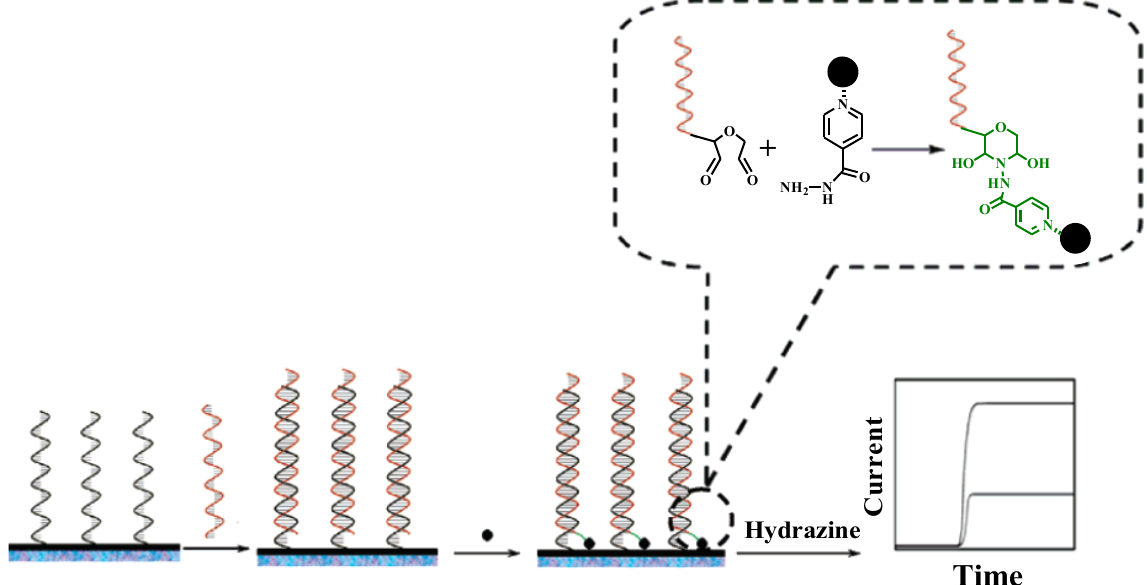
Figure 1. Schematic illustration of miRNA assay using electrocatalytic OsO Reprinted with permission from [13]. Copyright 2006 American Chemical